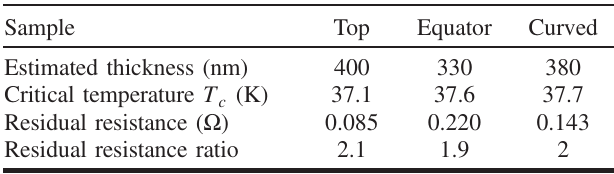
TABLE. III. A comparison between the MgB 2 films as deposited by the two-step deposition on the top three samples mounted on the 6 GHz dummy